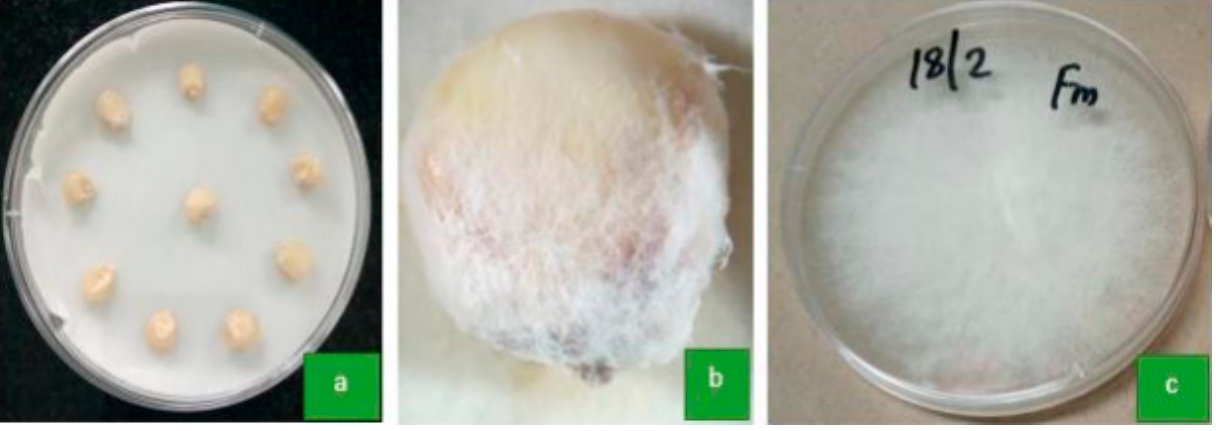
Figure 1. ( a ) Plated maize seeds; ( b ) Fungal growth on maize seed; ( c ) F. verticillioides inoculum in Petri dish.